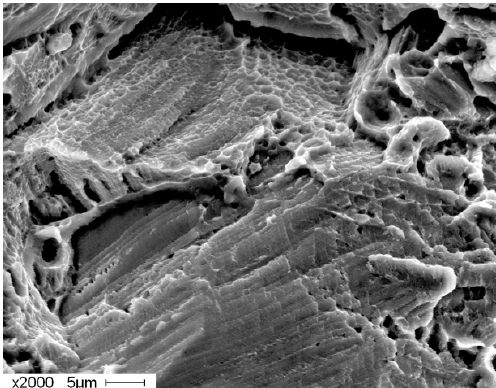
Figure 11. The SEM micrograph of the Cr-Mn-N steel fracture surface after the tensile test at 77 K. Brittle fracture fragments were observed along with ductile pits. A feature of the fracture surface was the layered structure of the brittle area, the size of which was commensurate with the grain sizes of 20–30 µ m. The γ / ε layered microstructure is shown in the TEM micrograph (Figure 10a). The layered fracture surface was formed as a result of the hcp lattice deformation by sliding along the (001) ε <110 > ε basal planes and the subsequent shear fracture.